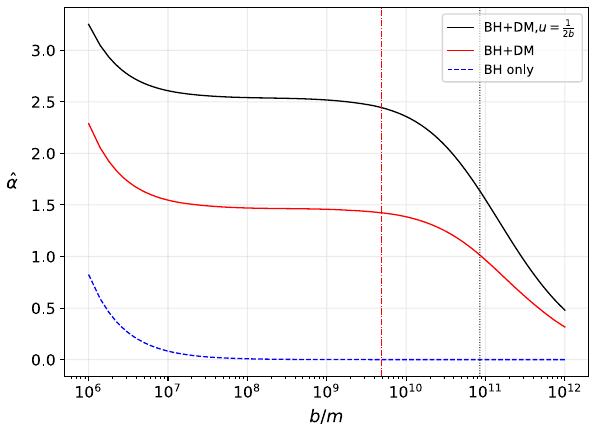
Fig. 2 Curve of the weak deflection angle in the CDM profile for dif- ferent values of the dimensionless impact parameter b / m in Sgr. A*. Here, ˆ α is in µ as. The vertical dotted line is the value of the outermost core radius r c ∼ 8 . 484 × 10 10 m . The region below the dash-dotted vertical line is the cusp region ( ∼ 4 . 86 × 10 9 m )